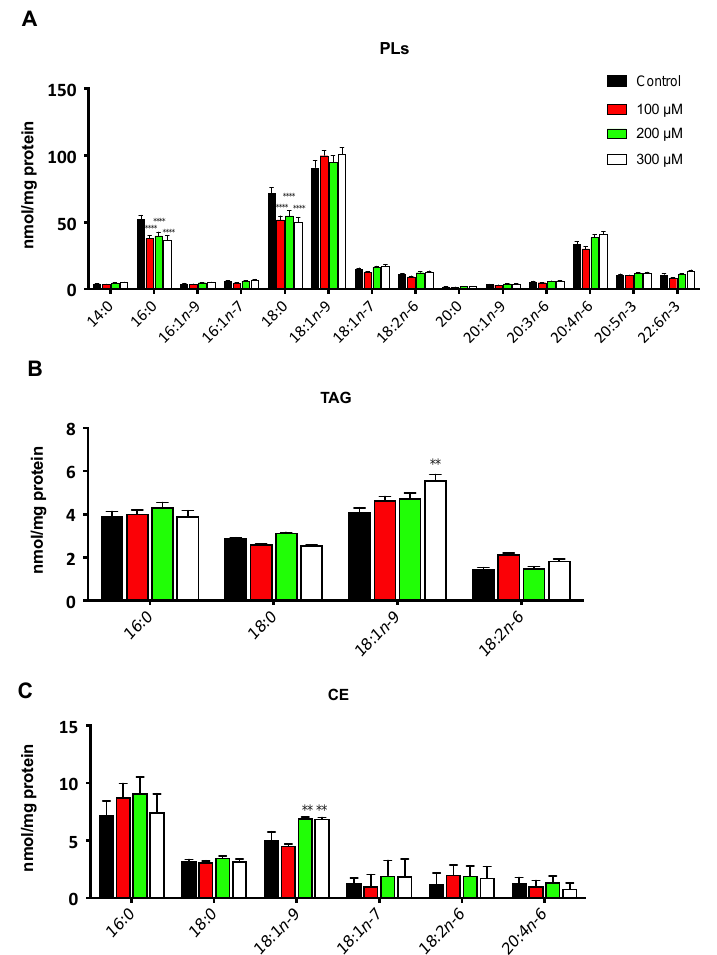
Figure 4. Lipidomic profile of the Caki-2 cells under hypoxic conditions. The cells were treated with the indicated concentrations of CoCl 2 , and ( A ) the fatty acid contents in the phospholipids (PL), ( B ) triacylglycerol (TAG) and ( C ) cholesterol esters (CE) were determined by GC/MS. Data are expressed as the means ± SEM and are representative of three independent experiments. ** p < 0.01 and **** p < 0.0001, significantly different from the control.